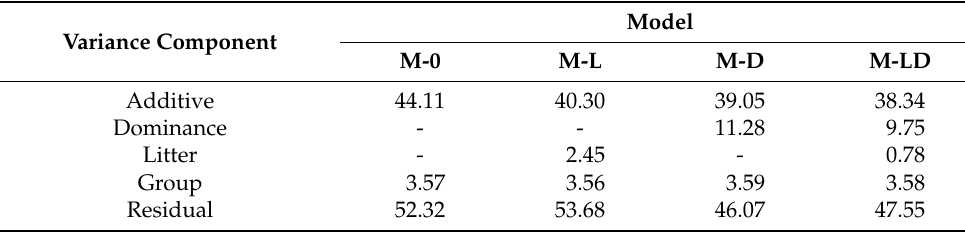
Table 2. Average contribution (%) of variance components to the total phenotypic variance estimated for the investigated traits with four models (M-0, M-L, M-D, M-LD) 1 . Model Variance Component M-0 M-L M-D M-LD Additive 44.11 40.30 Dominance -